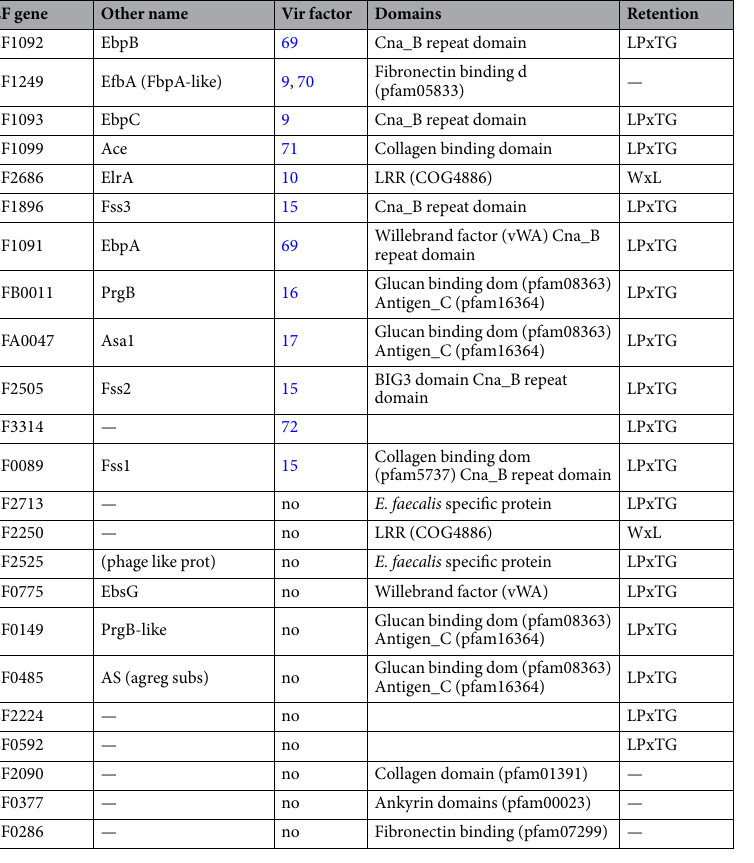
Table 1. Description of the 23 E. faecalis selected